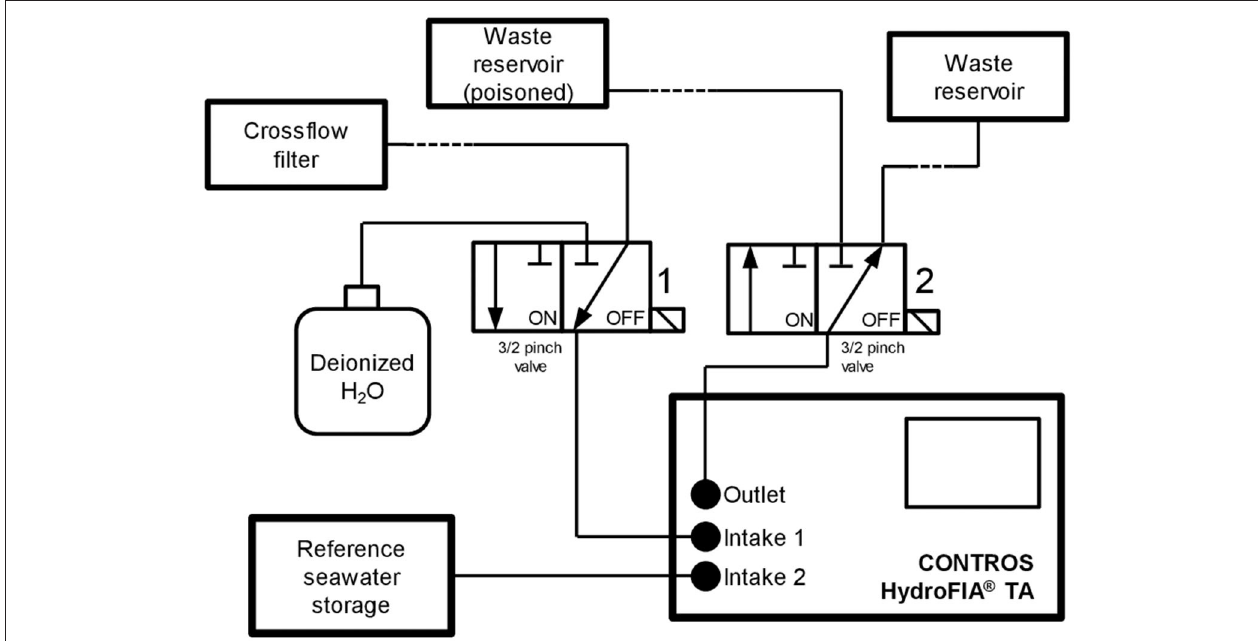
FIGURE 3 | Schematic illustration (not to scale) of the onboard installation for seawater TA